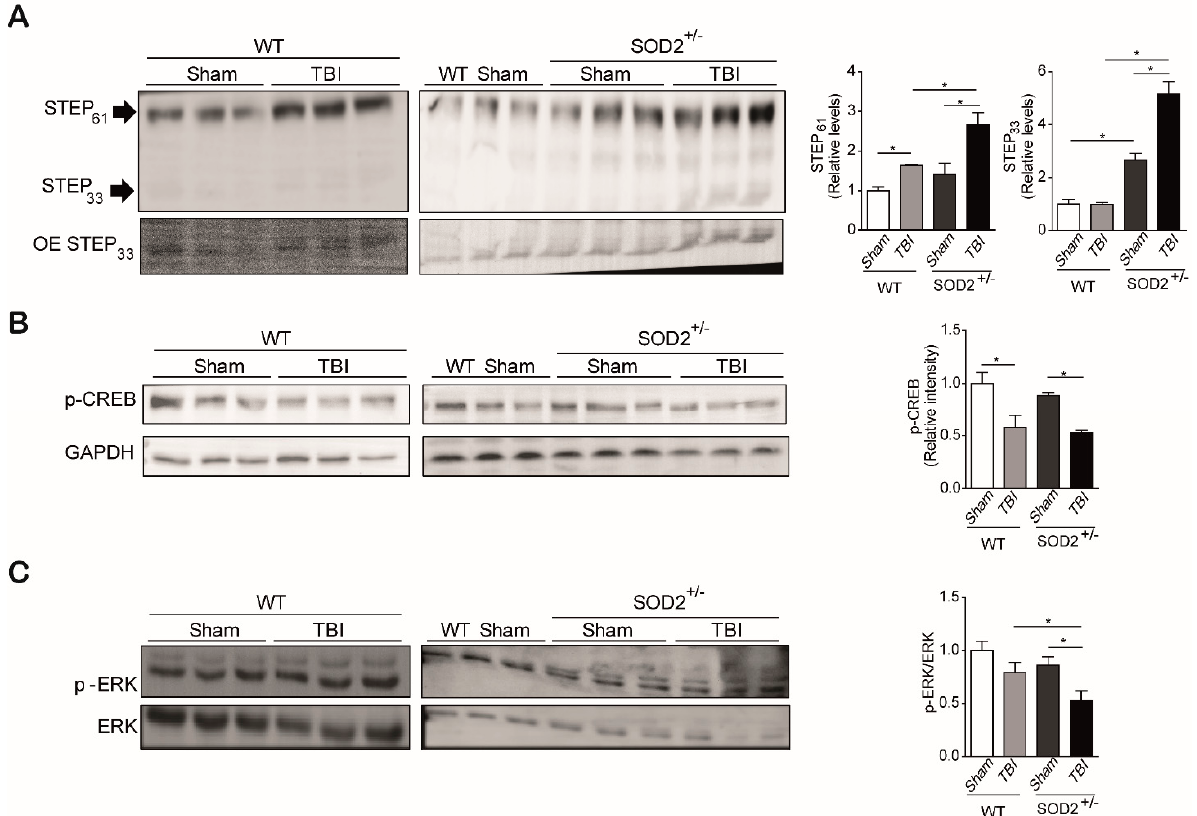
Figure 6. STEP 61 and NMDARs associated signaling are altered in WT and SOD2 +/- mice after TBI. Immunoblot and densitometric analysis of STEP 61 , STEP 33 ( A ), p-CREB ( B ), and p-ERK ( C ) from hippocampi lysates from WT and SOD2 +/- mice after TBI. Three animals were used per experimental group. Data are means ± S.E. Statistical differences were calculated by ANOVA, followed by post hoc Bonferroni’s test. Asterisks indicate the statistical significance of the observed differences (* p <0.05). OE, overexpression.